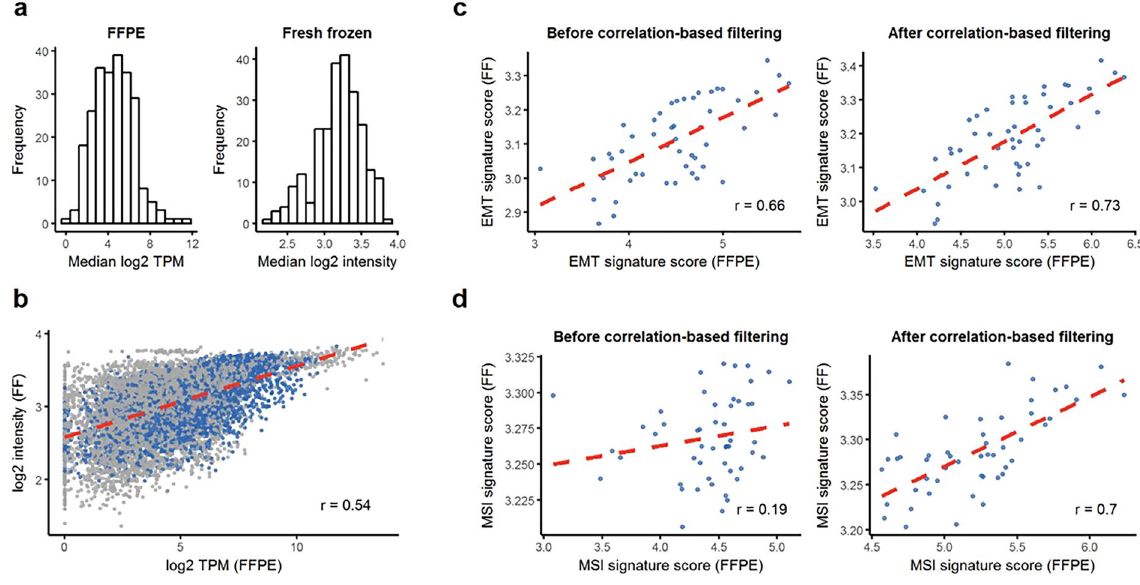
Figure 2. Overall gene expression and comparison between fresh frozen (FF) (Microarray) and FFPE (RNA- Seq). ( a ) Histogram of log2 expression values of signature genes in FF and FFPE. ( b ) Paired log expression value scatter plots across all sample and signature genes. Gene expression values that pass correlation filtering are indicated as blue dots. ( c ) EMT signature scores for FF and FFPE before/after filtering. ( d ) EMT signature scores for FF and FFPE before/after filtering.